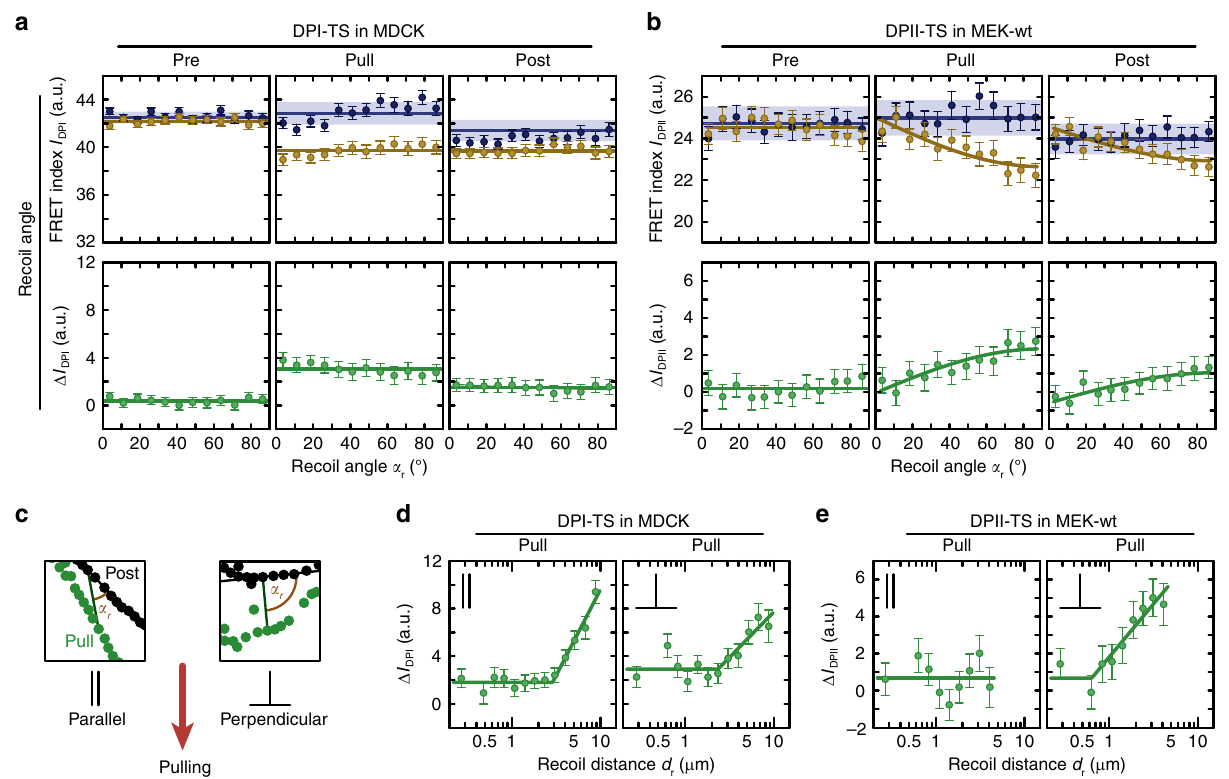
Fig. 5 DPII loading is sensitive to the orientation and magnitude of the applied deformation. a Tension across DPI in MDCK cells did not depend on the recoil angle. Data are from the pulling experiment represented in Fig. 3d. b In MEK-wt, DPII tension increased for increasing recoil angles. Data are from the pulling experiment represented in Fig. 3e. c Puncta were classi fi ed as parallel ( α r ≤ 45°) or perpendicular ( α r > 45°) to pulling direction. d The effect of magnitude and orientation of the external deformation showed no apparent additive effect for DPI-TS in MDCK monolayers. e The effect of magnitude and orientation of the external deformation were additive for DPII-TS in MEK-wt. a – e The mean FRET index of DP-TS and DP-ctrl as well as the mean difference between DP-TS and the mean of all DP-ctrl puncta were calculated using the lmer-test and displayed with the 68% CI. Blue lines and corresponding shading indicate the mean with 95% CI of all DP-ctrl puncta. Yellow and green lines are guides to the eye. Source data are provided as a Source Data fi α = 90°. We then plotted FRET differences of the pre, pull, r and post state according to the recoil angle α r (Fig. 5a, b).